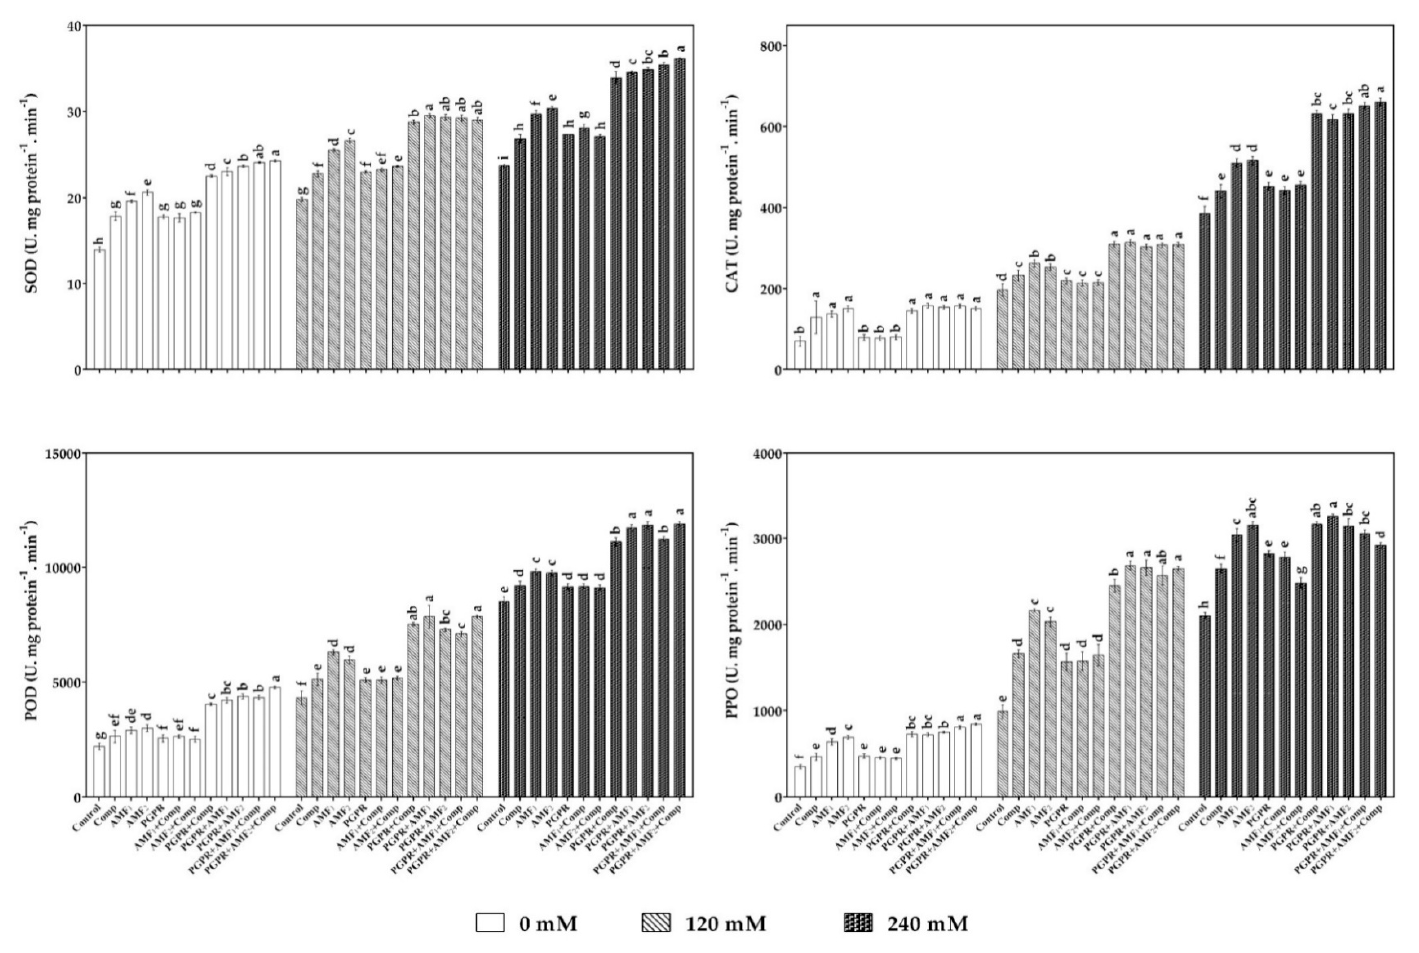
Figure 4. Effects of salt stress and biofertilizers on superoxide dismutase (SOD), catalase (CAT), peroxidase (POD) and polyphenol oxidase (PPO) activities in date palm vitroplants. Comp: compost; AMF 1 : AMF consortium; AMF 2 : AMF pure strain; PGPR plant growth promoting rhizobacteria. Data presented are means ± standard deviations, n = 3. Bars followed by the same letters within the same salt stress level are not significantly different according to Student–Newman–Keuls test ( p < 0.05).